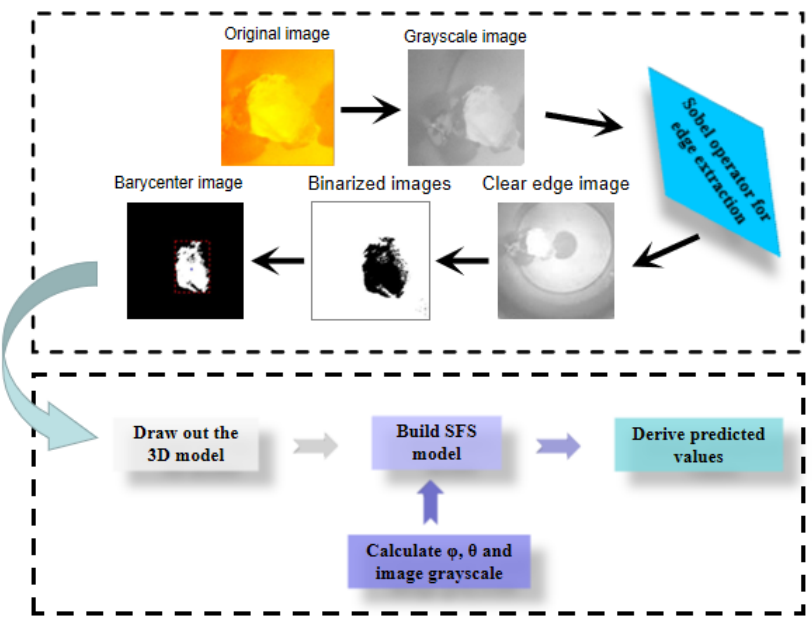
Figure 9. Flow chart for calculating the melting rate of silicon dioxide particles.